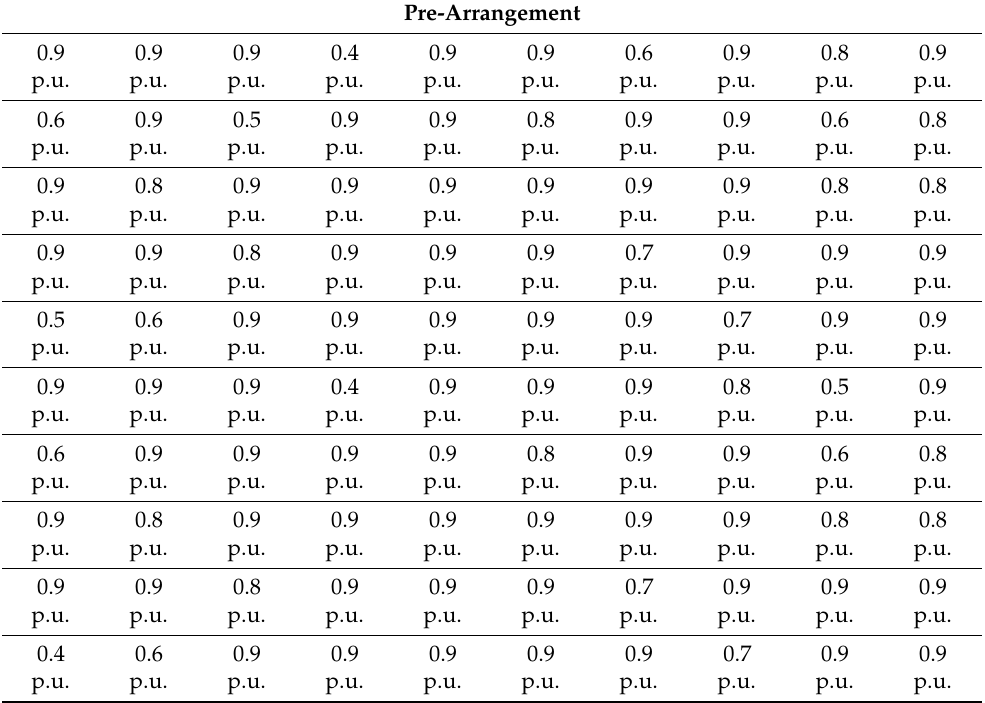
Table 2. PV array 10 × 10 parameters before arrangements.